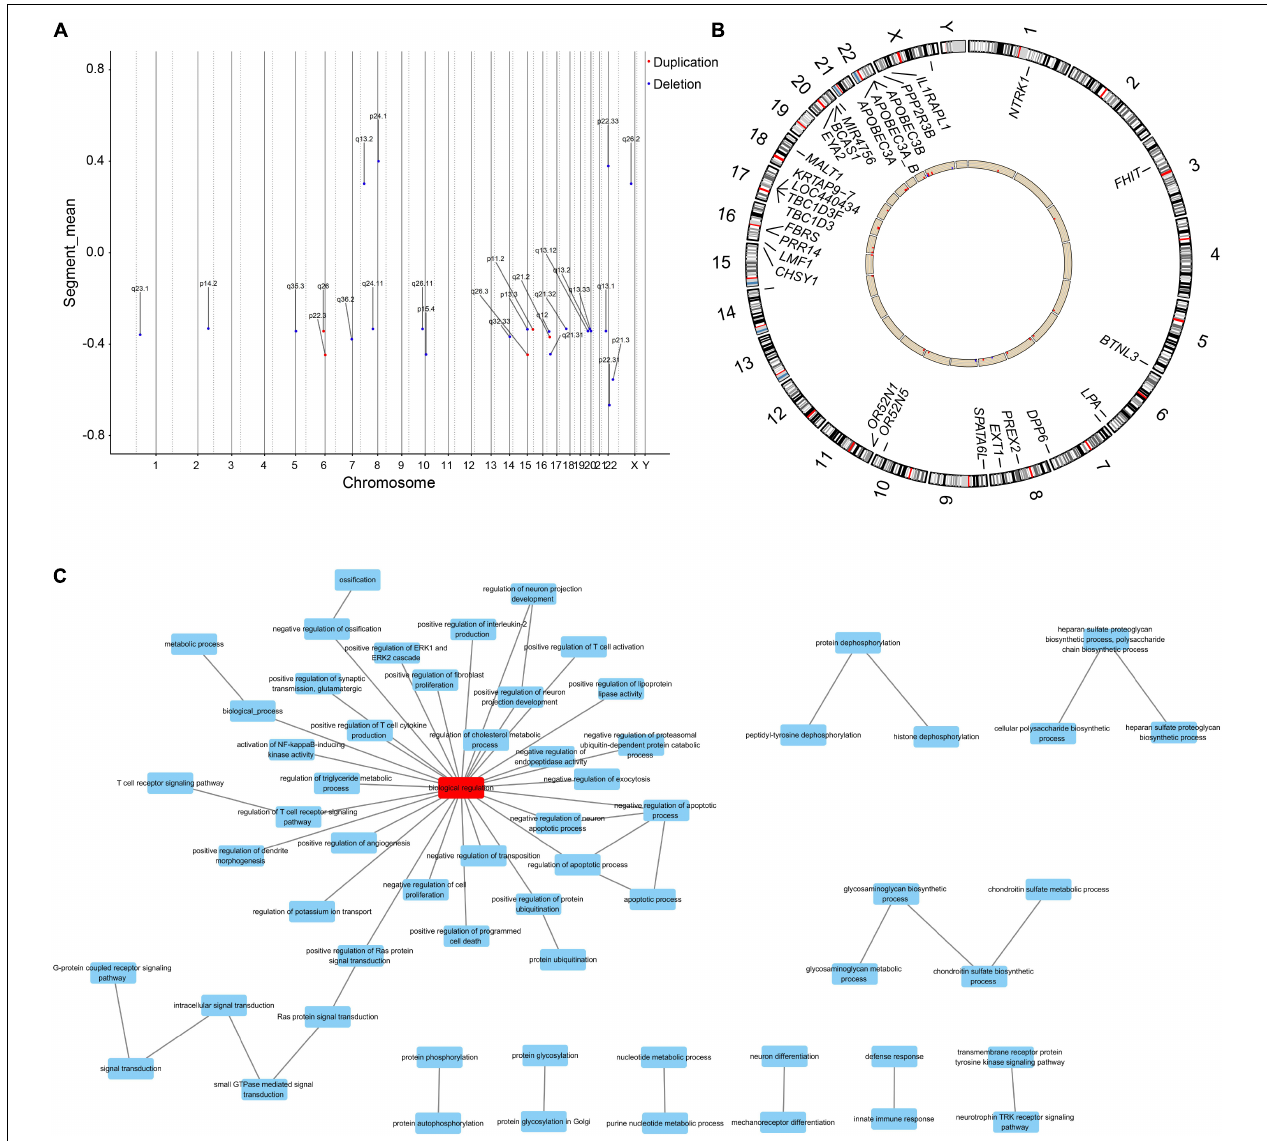
FIGURE 2 | The differential genes linked to aberrant CNVs are enriched in metabolism-related biological functions. (A) Distributions of aberrant CNVs on each chromosome. Red and blue dots indicate whether the type of the CNV is duplication or deletion, respectively. (B) Distribution of differential genes within the region of differential CNVs in the genome. Red columns indicate that the copy number of this gene is increased in PE patients compared to controls, and blue columns indicate a decrease. (C) Differential genes were enriched in functions associated with lipid and cholesterol metabolism, immunity, and